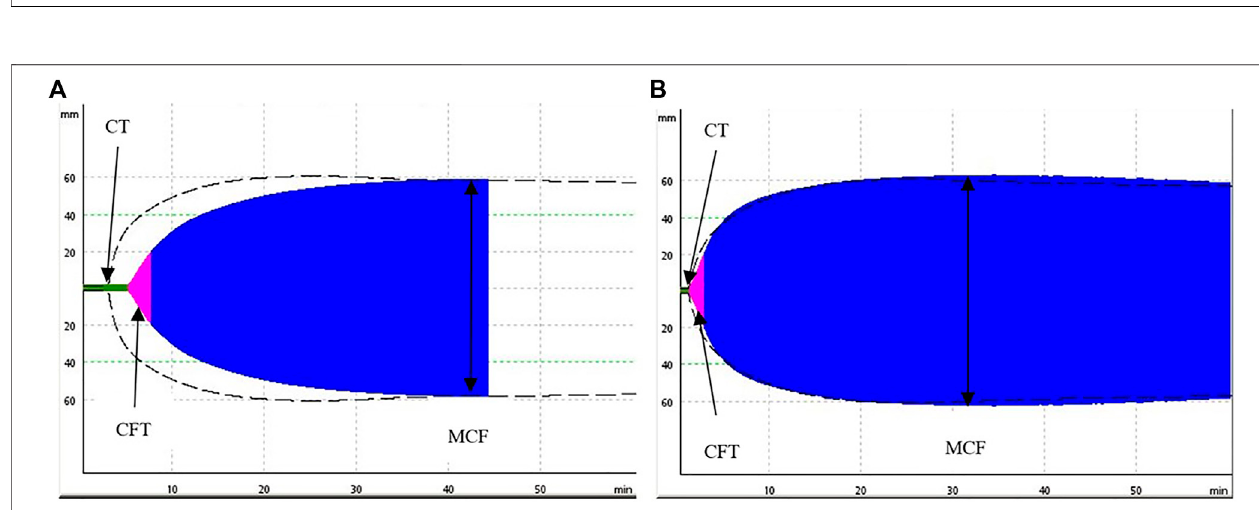
FIGURE 1 | In fl uence of temperature (x-axis, temperature in degrees Celsius) on ROTEM EXTEM standard parameters (y-axis, seconds in (A) and (C) ; mm in (B) and degrees in (D) ; mean values with respective 95% con fi dence interval (CI) are shown). * indicates signi fi cant differences to baseline at 37 ° C ( p -values < 0.05).